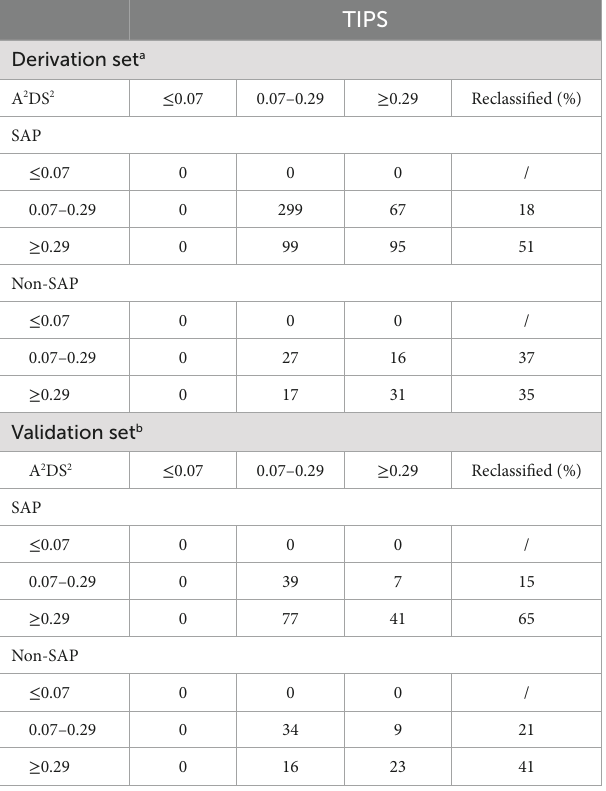
TABLE 3 Reclassification results for stroke-associated pneumonia in both the derivation set and validation set.